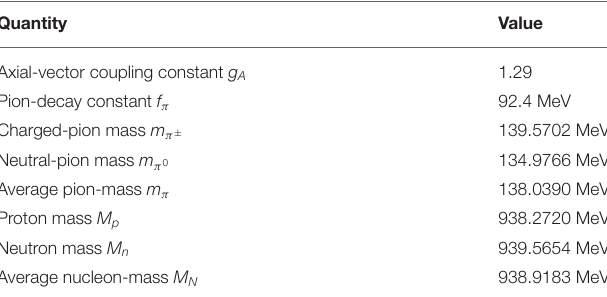
TABLE 1 | Basic constants used throughout this review